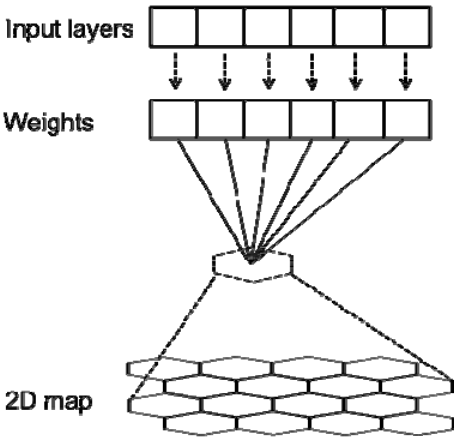
Figure 3. Illustration of how an SOM